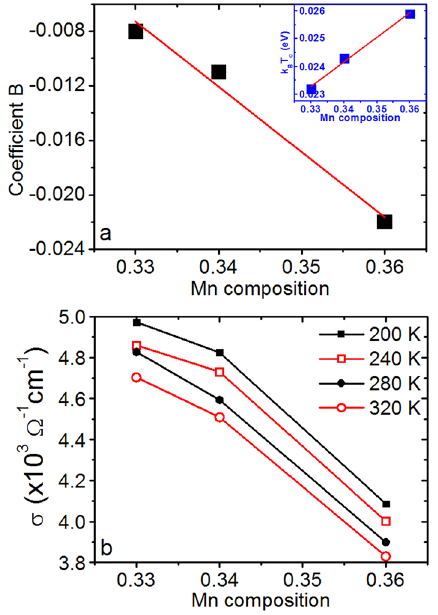
Figure 4. Electrical properties of the Mn x Co y Ge 1− x − y thin films. ( a ) electron-scattering-dependent parameter B (Eq. 4) as a function of x . The inset shows the k B T c energy variation versus x . ( b ) Electrical conductivity as a function of x , measured at different